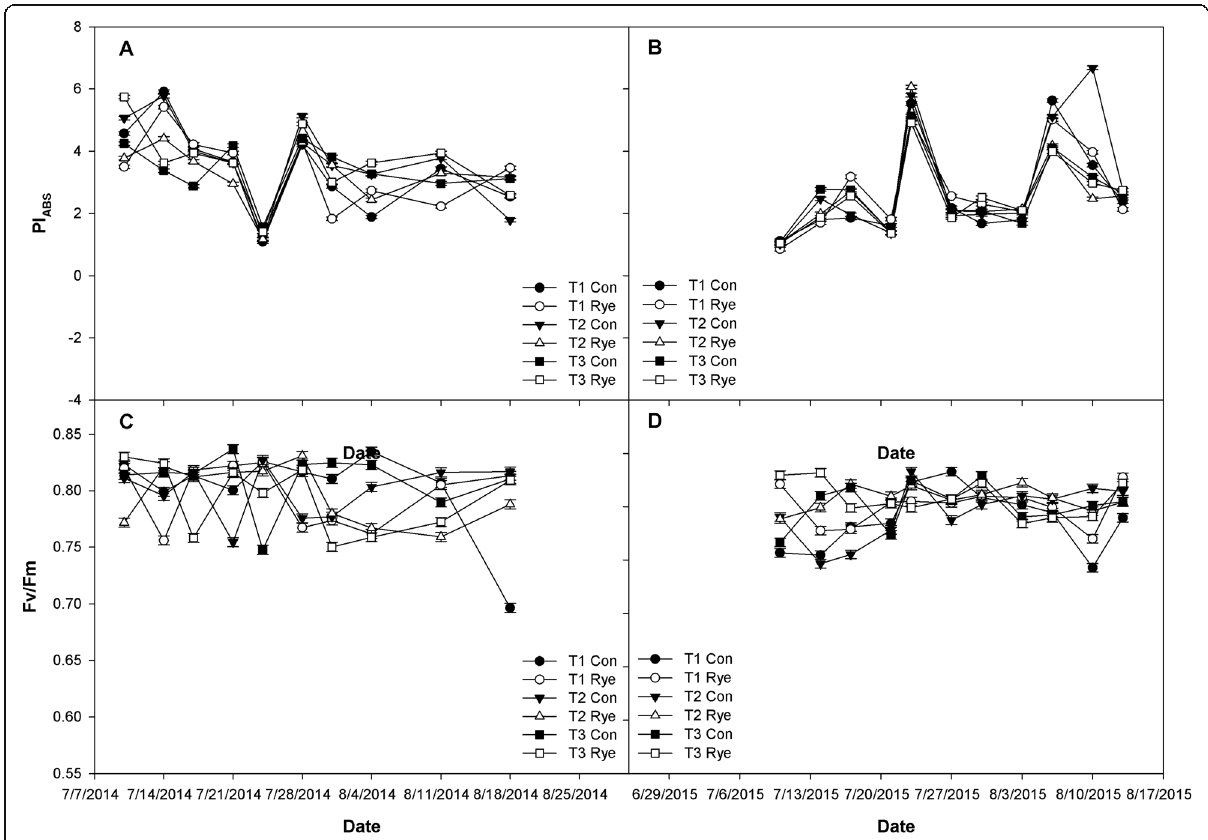
Fig. 7 Photosynthetic performance index (PI ABS ) and maximum quantum yield of photosystem II (F v /F m ) for the 2014 ( a , c ) and 2015 ( b , d ) cotton crop grown under irrigation regimes T1-T3 and planted into either conventionally tilled beds (Con) or a heavy rye cover crop residue (Rye) at a field site near Tifton, GA. Values are means ± standard error ( n =